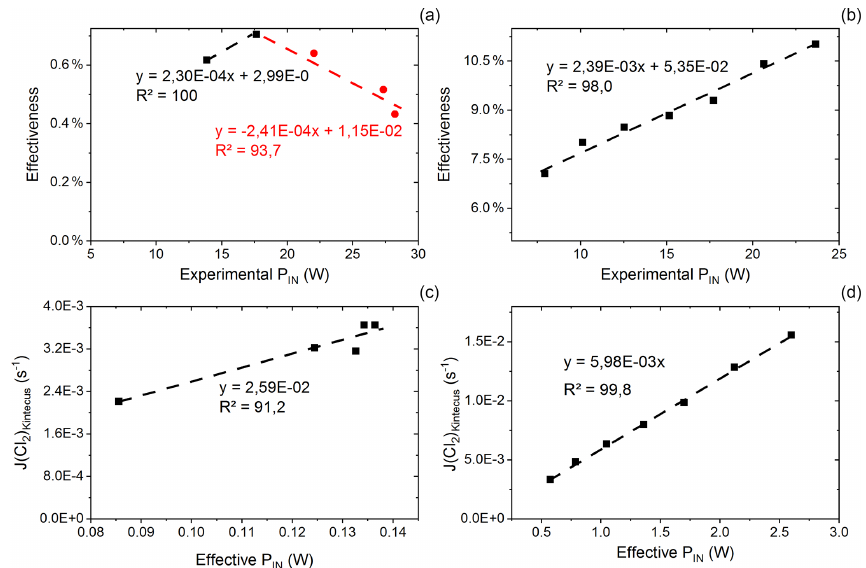
Figure C1. (a) Effectiveness as a function of experimental power input for exp. D. The correlation is used for calculating the effective P IN for single-tube experiments. (b) Effectiveness as a function of experimental P IN for exp. I. The correlation is used for calculating the effective power for multiple-tube experiments. (c) Kintecus-obtained J Cl as a function of the effective p IN for exp. D. The effective p IN is calculated 2 from Fig. C1a. The combination of the figure with Fig. C1a is used to calculate the J Cl for single-tube experiments by Eqs. (C19) and (C20). 2 (d) Kintecus-obtained J Cl as a function of the effective p IN in exp. I. The effective p IN is calculated from Fig. C1b. The combination of the 2 figure with Fig. C1b is used to calculate the J Cl for multiple-tube experiments by Eq. 2